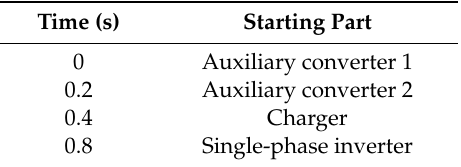
Table 2. Logic start-up sequence of auxiliary power supply system.